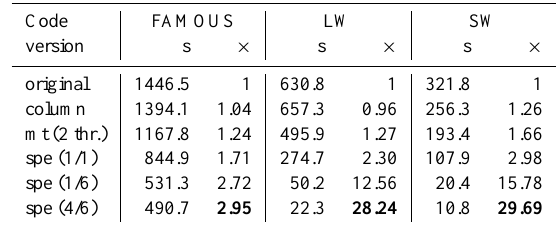
Table 2. The computation times (in seconds) and speed-up factors (columns marked with ’ × ’) of FAMOUS, the short-wave radiation (SW), and the long-wave radiation (LW) for the different code ver- sions. The time indicated for FAMOUS excludes the work done during the start-up of the program. The model was run for 720 atmosphere time-steps. For the spe version, the number between parentheses indicate how many columns were computed simultane- ously using SIMD, and how many SPEs were used concurrently.